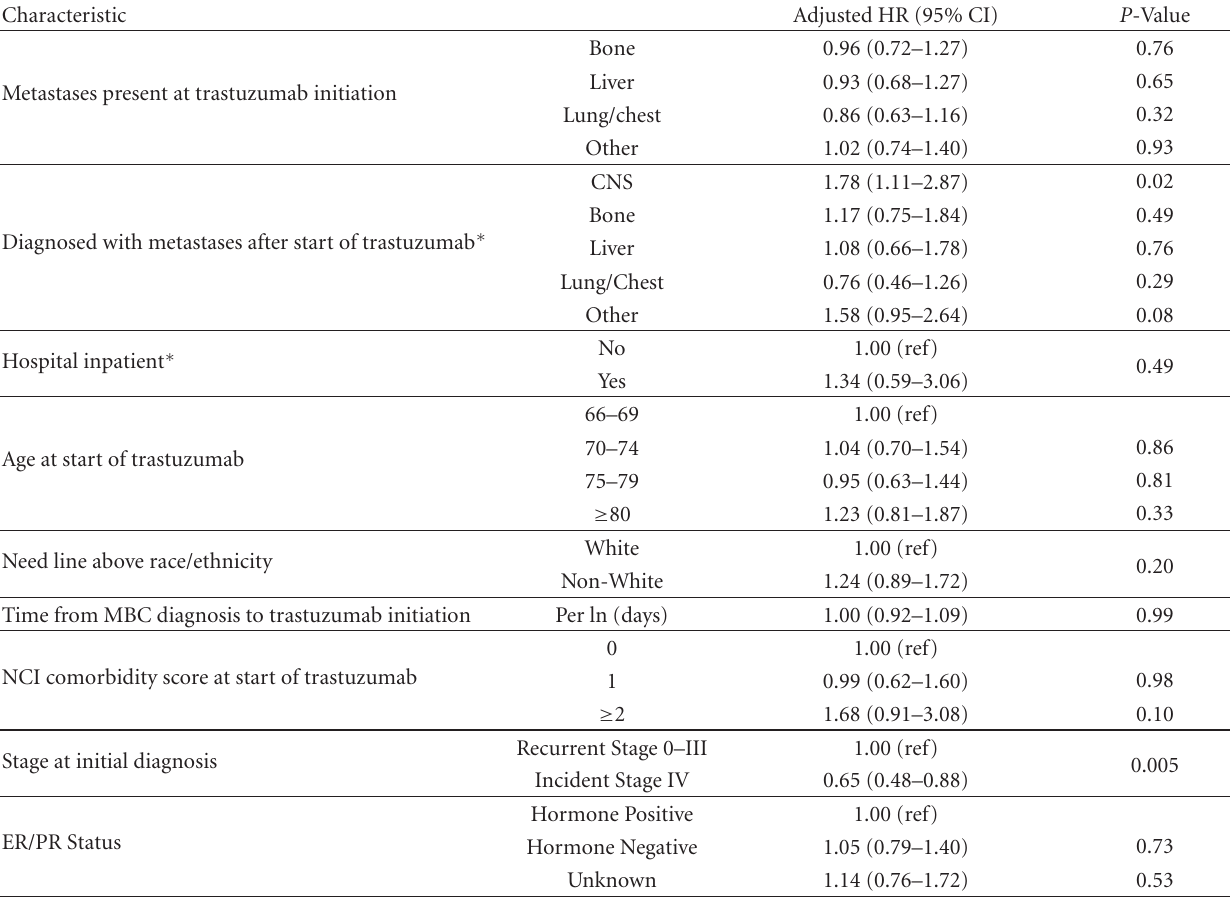
Table 3: Adjusted model for risk of permanent discontinuation of